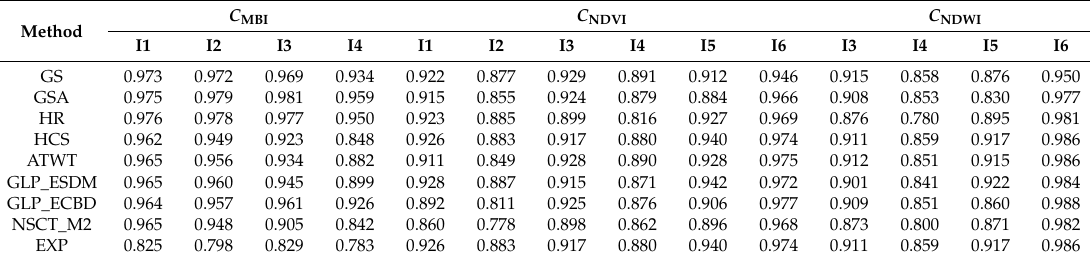
Table 5. The CC values for the information indices for the fused images generated by the selected eight